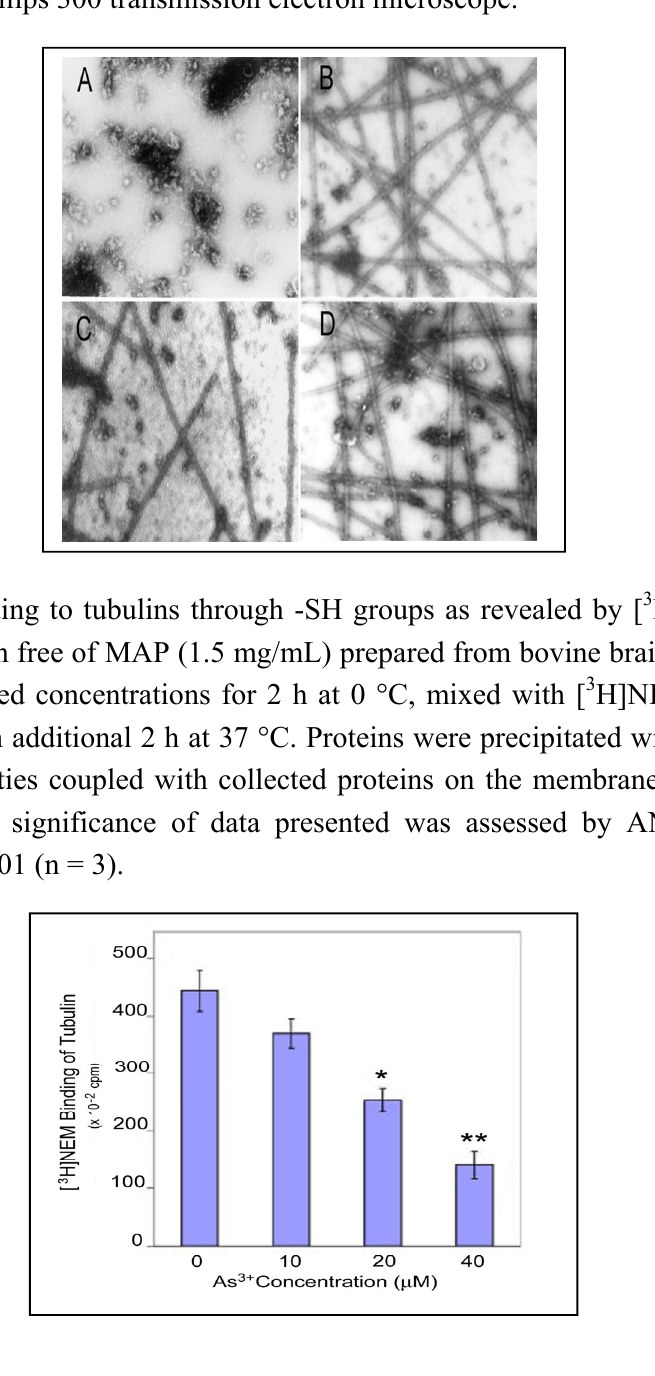
[ 3 H]NEM to tubulin with 50% inhibition occurring at 23 µM. This straightforward experiment shows As 3+ binding to tubulin through -SH groups, initiating the cascade of MT disruption events. Figure 6. As 3+ -inhibition of MT protein polymerization in vitro as confirmed by EM examination. The in vitro MT polymerization was carried out as described in Figure 5. At the plateau level of the MT assembly (30 min after reaction), a 10 µL-drop of the reaction mixture was removed and processed for EM examination. ( A ) the absence of polymerized MTs at 0 min; ( B ) the typical morphology of in vitro assembled MTs at 30 min; ( C ) 40 µM As 3+ ; ( D ) 40 µM As 3+ plus 1 mM DTT. Photographs with a final magnification of 22,000 × observed under a Philips 300 transmission electron microscope.